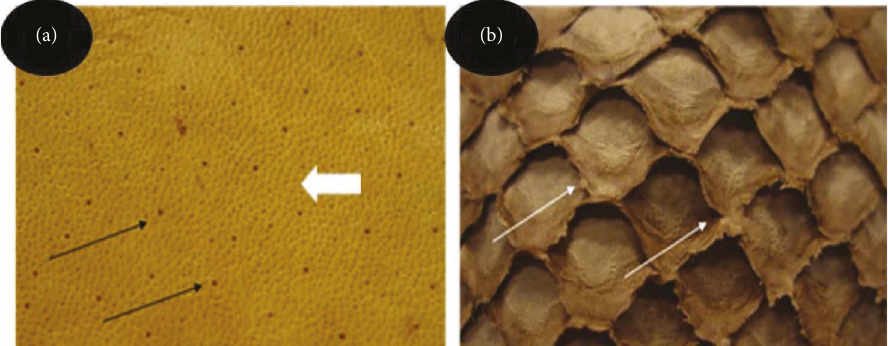
Figure 3: Flower design of rabbit (a) and Nile tilapia (b) leather. (a) The surface of the leather, after hair removal, performed in the tanning process, shows the pores (white arrow) and hair follicle openings (black arrow), from which the hairs project; (b) protective lamellae and insertion of the scales. The white arrows indicate the point of union between these lamellae and the dotted indicates the opening of the lamellae.